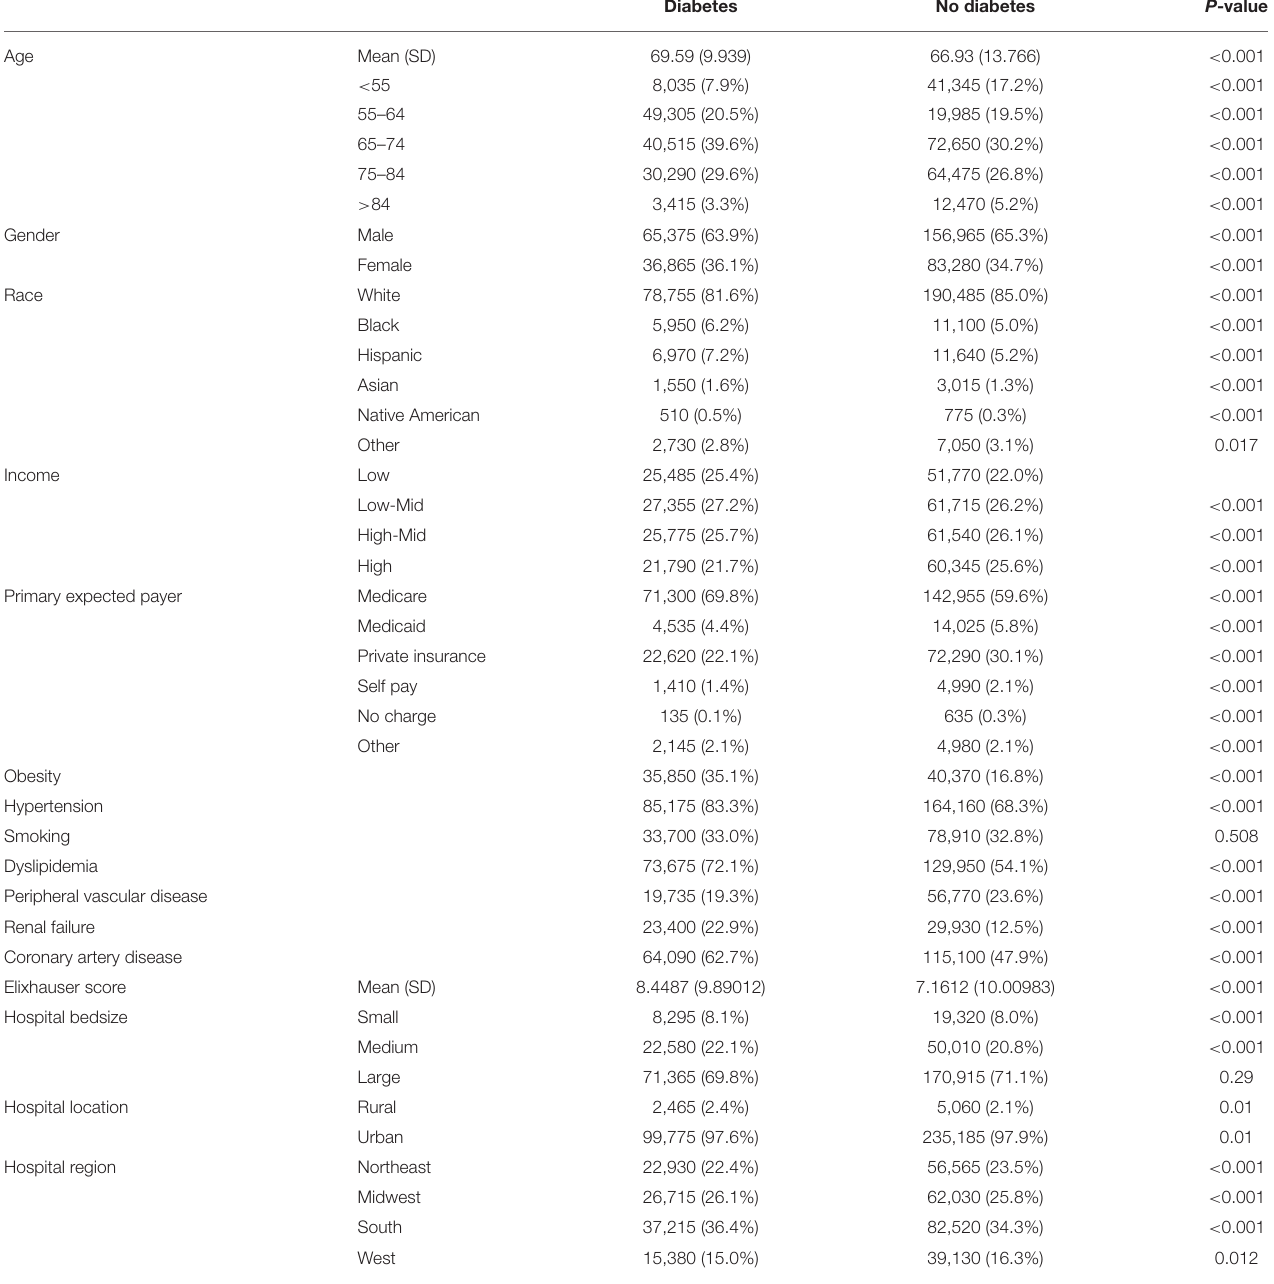
TABLE 5 | Comparison of patients with vs. without diabetes undergoing